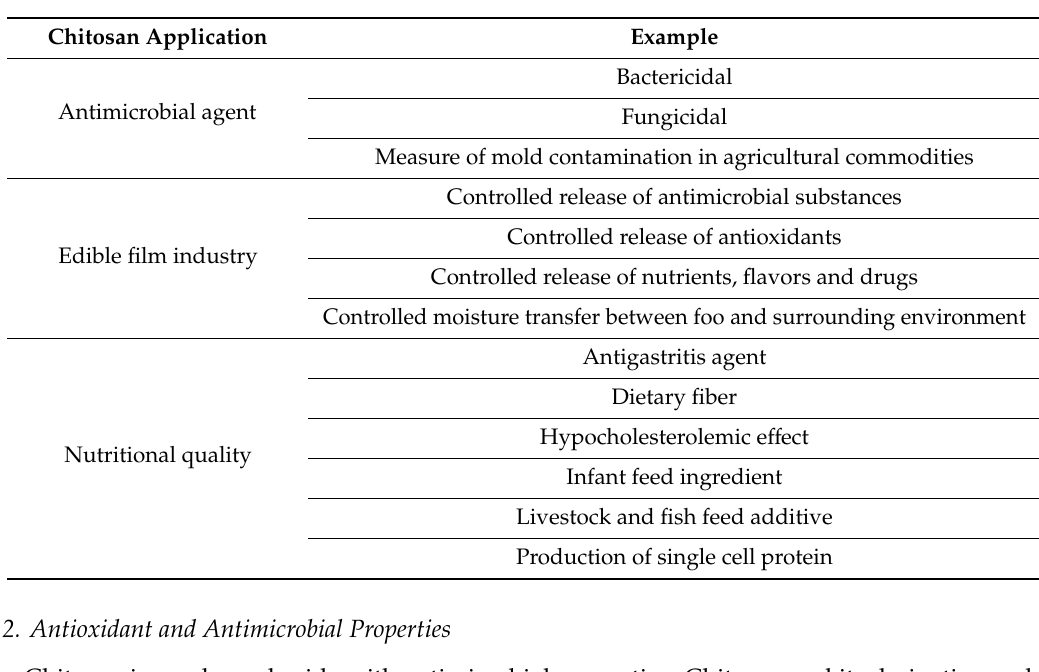
Table 8. Some microbial applications of chitosan and chitosan derivatives.